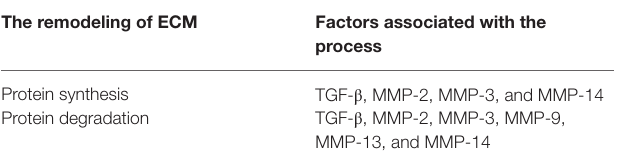
TABLE 1 | LLLT regulates the remodeling of ECM. The remodeling of ECM Factors associated with the process Protein synthesis TGF- β , MMP-2, MMP-3, and MMP-14 Protein